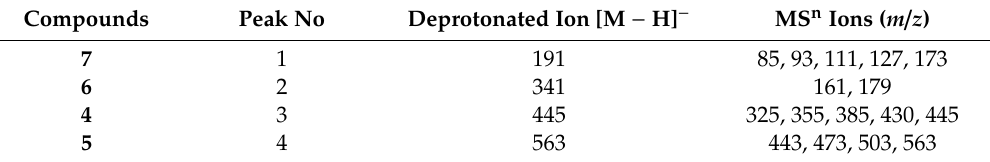
Table 1. Compounds identified in Machaerium hirtum by ESI-MS n .